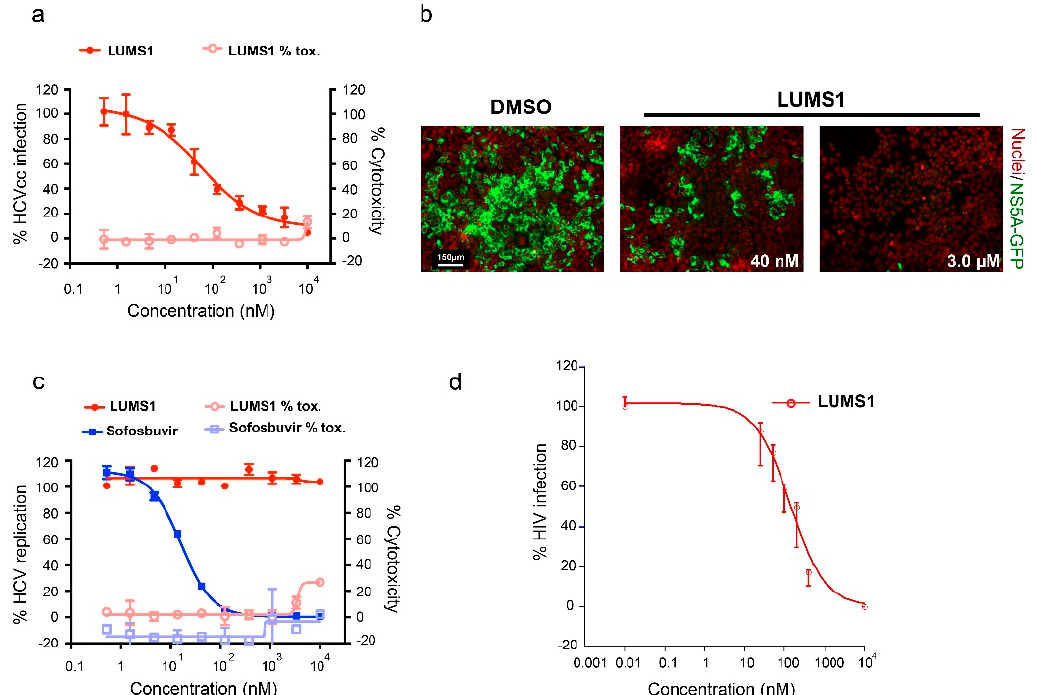
Figure 4. Hepatitis C virus (HCV) inhibition by LUMS1: ( a ) Anti-HCV activity in Huh-7.5 cells. Cells were pretreated with increasing concentrations of LUMS1 for 2 h followed by infection with HCVcc (JFH1) for 72 h in the presence of proteins. ( b ) HCV infectivity and total cell number were assessed by determining the number of GFP-positive cells (green) and nuclei (red), respectively, for 3 days in the presence of LUMS1). Images were acquired by confocal microscopy. ( c ) HCV subgenomic replicon cells were treated with LUMS1 and sofosbuvir. ( d ) HCVpp was mixed with different concentrations of LUMS1 and subsequently added to Huh-7.5 cells. After 72 h incubation, cells were lysed and percent infection was measured through luciferase activity (BrightGlo, Promega, USA) for each dilution of inhibitor with respect to control containing no inhibitor.